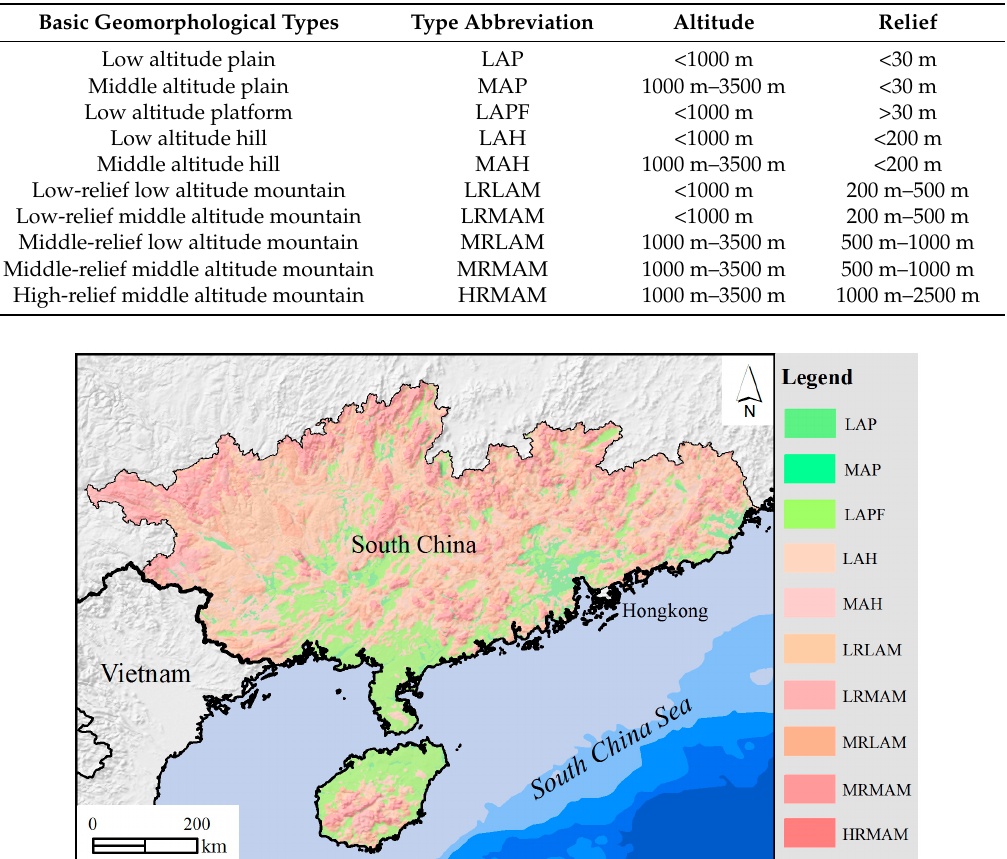
Figure 3. Spatial distribution of the basic geomorphological types in South China.